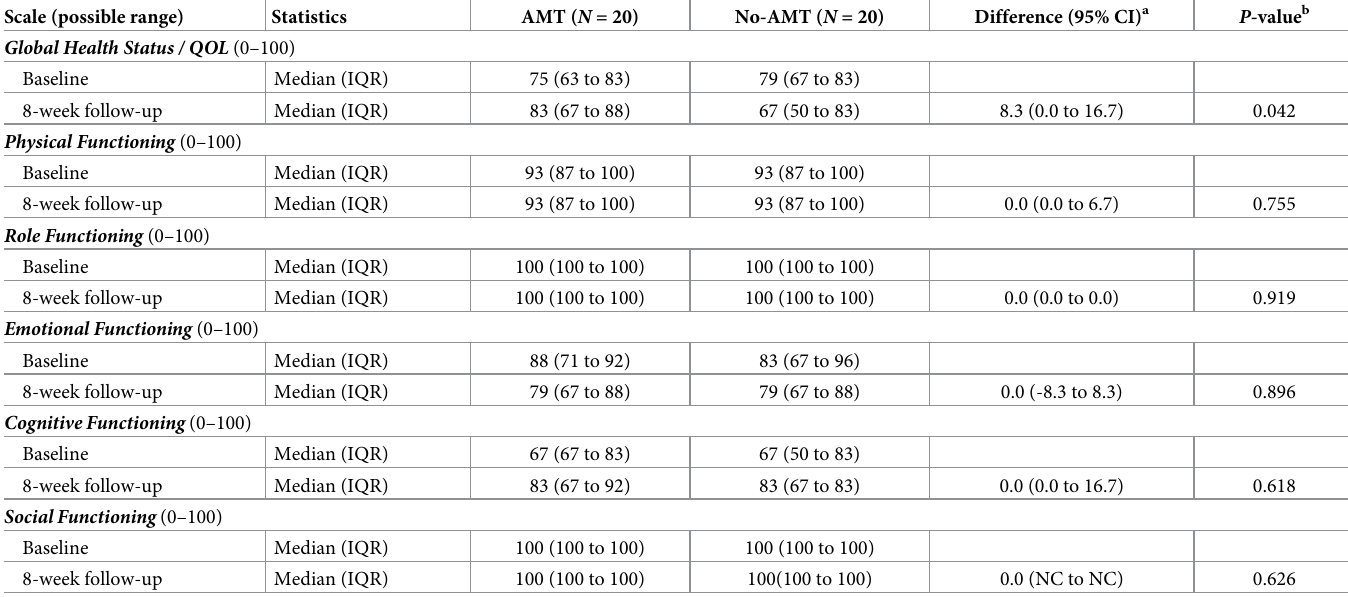
Table 2. Analyses of EORTC QLQ-C30 Global and functioning